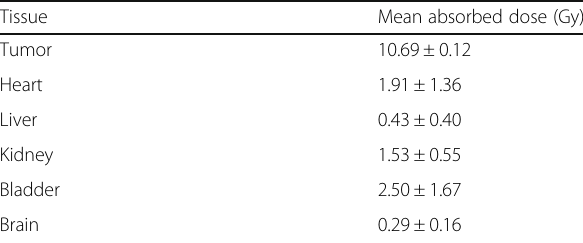
Table 2 Mean absorbed dose of 18 F-FDG in different tissue/ organs after i.t. 18 F-FDG estimated by using the Fricke chemical primary standard dosimeter